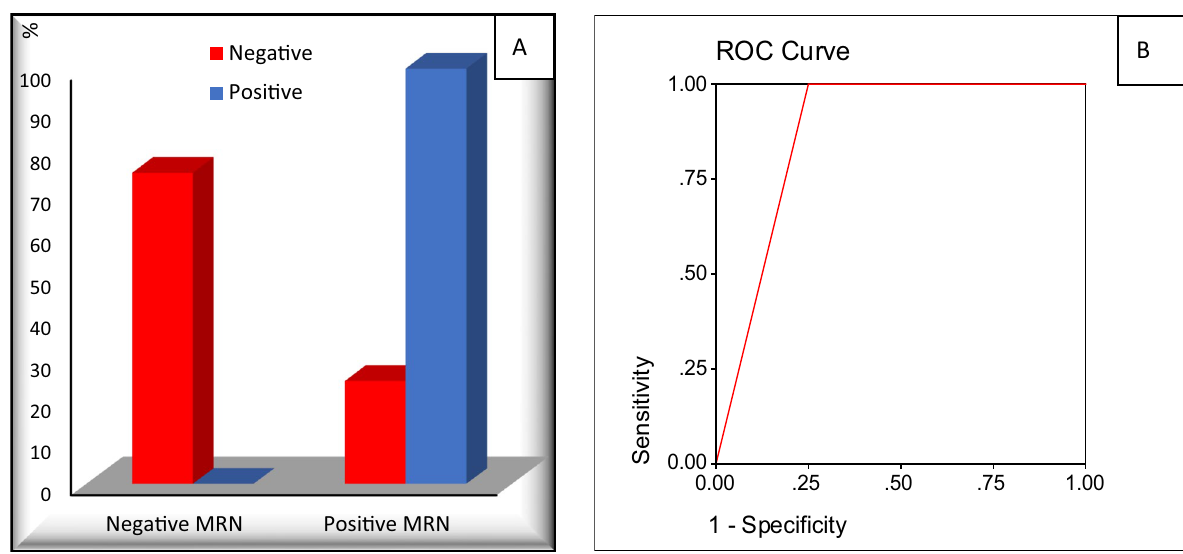
Fig. 2 Comparison between MRN and electrophysiological studies ( A ) and receiver operating characteristics (ROC) curve ( B ) shows sensitivity and specificity of